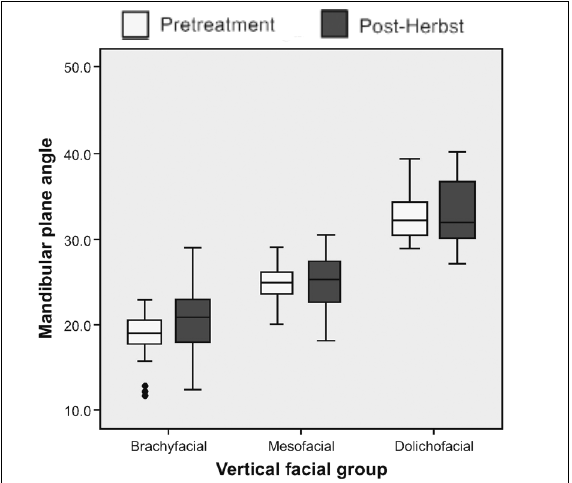
Figure 4. Pretreatment and post-Herbst mandibular plane angle (degrees) for the three vertical facial